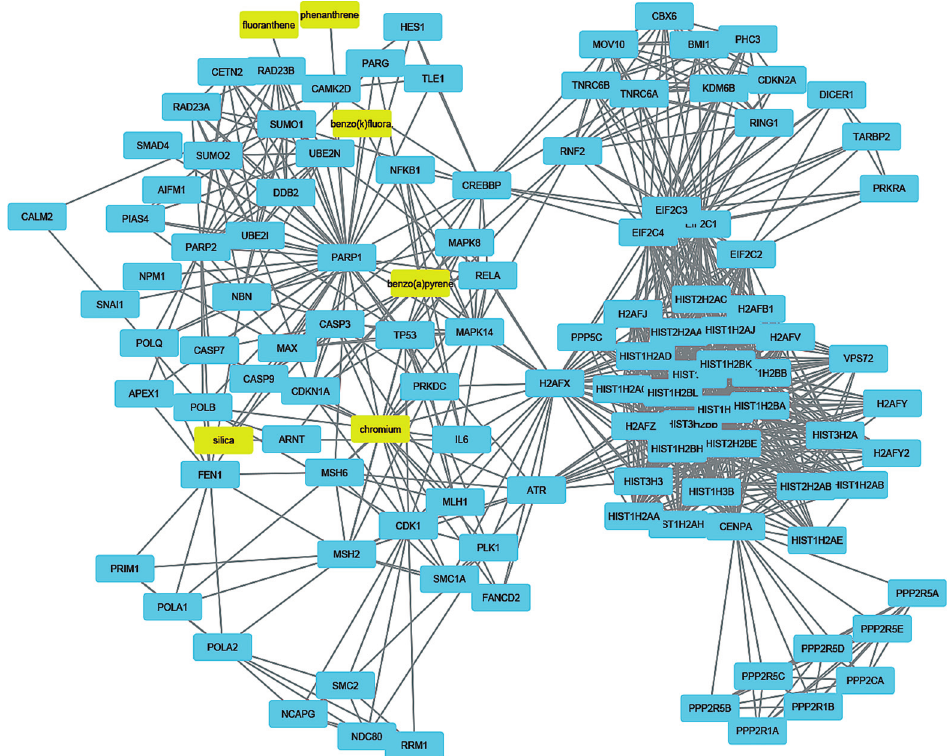
Figure 3 - Cluster analysis of the major CPI-PPI network showing the association of cluster 11 with MIOs, IEs, and PAHs (yellow). It is composed of 117 nodes and 867 edges, with Ci = 14,695. The associated constituents are SiO 2 , Cr, benzo[b]fluoranthene, fluoranthene, phenanthrene and benzo[a]pyrene.